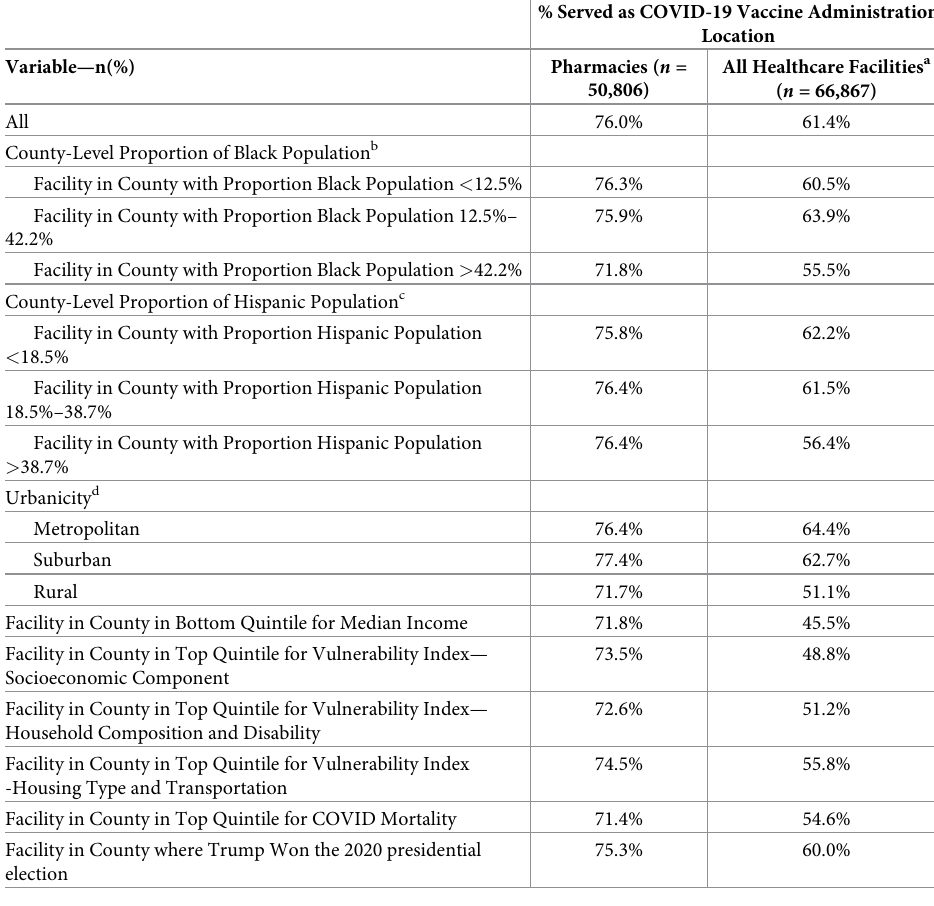
Table 1. Proportion of facilities serving as COVID-19 vaccine administration